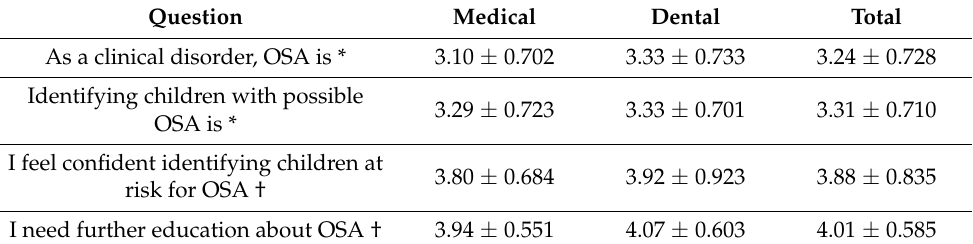
Table 4. Mean and SD of participants’ responses in attitude questions about pediatric OSA.